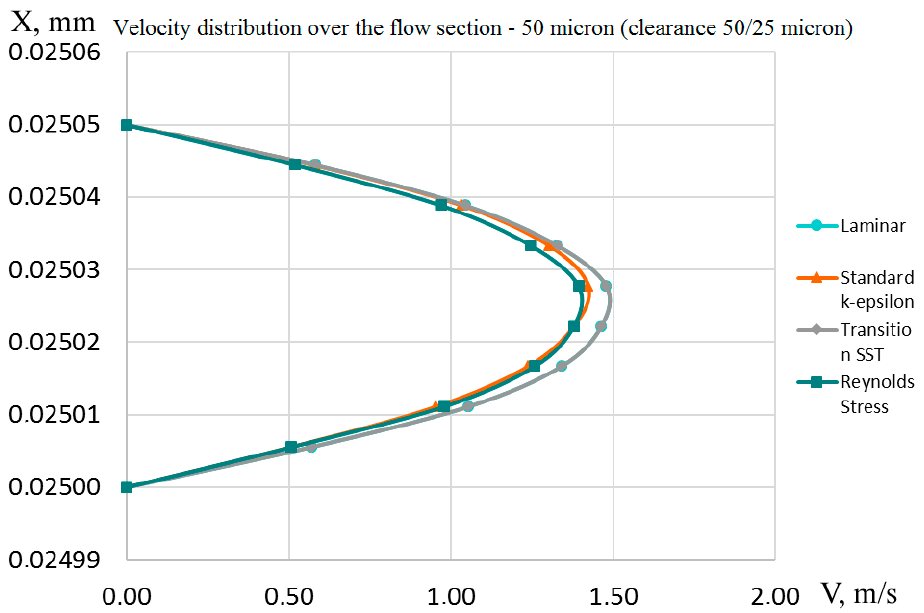
Figure 9. Velocity distribution over the flow section (laminar and transition SST curves match).